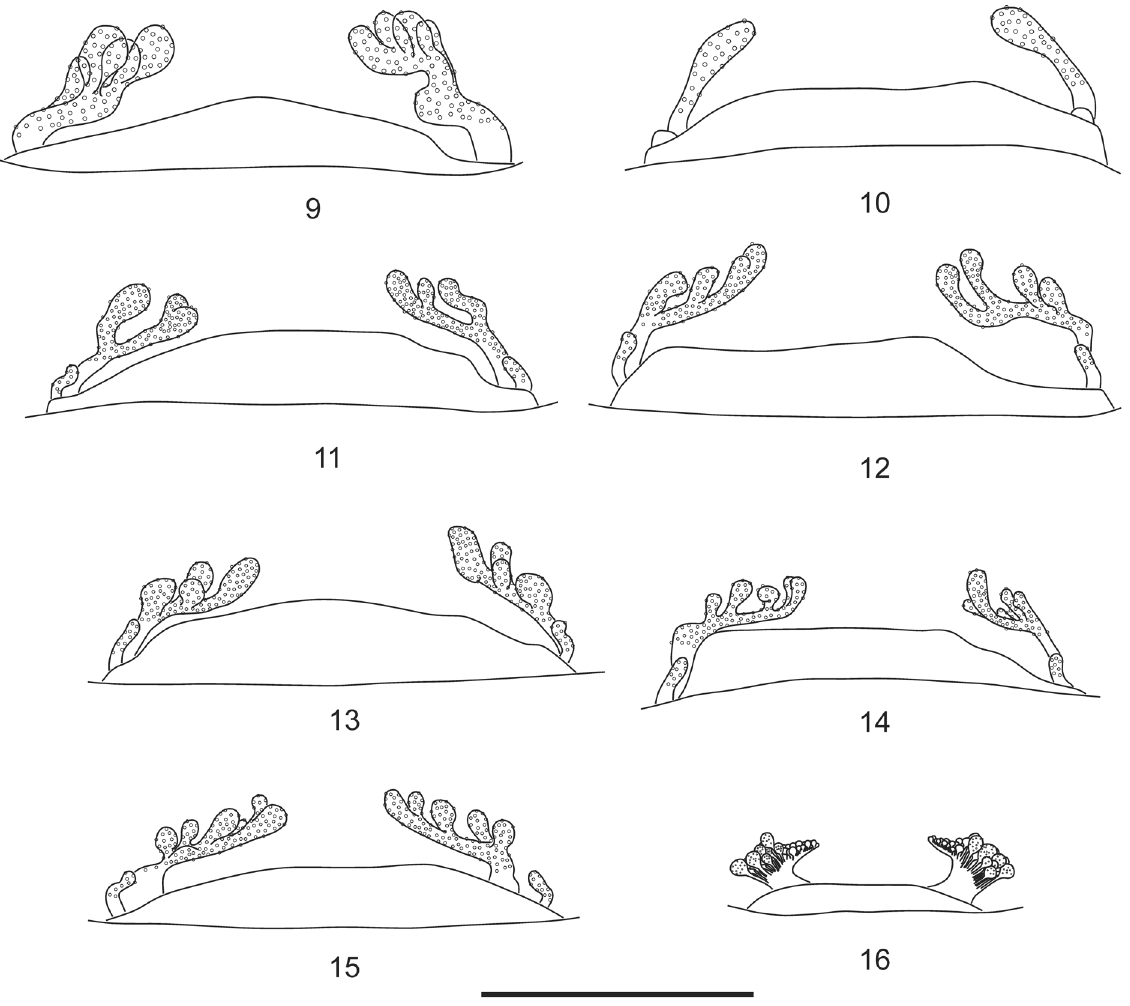
Figs 9–16. Female internal genitalia. 9 . Hexophthalma damarensis (Lawrence, 1928). 10 . H. dolichocephala (Lawrence, 1928). 11–15 . H. hahni (Karsch, 1878). 16 . H. spatulata (Pocock, 1900). Scale bar = 10